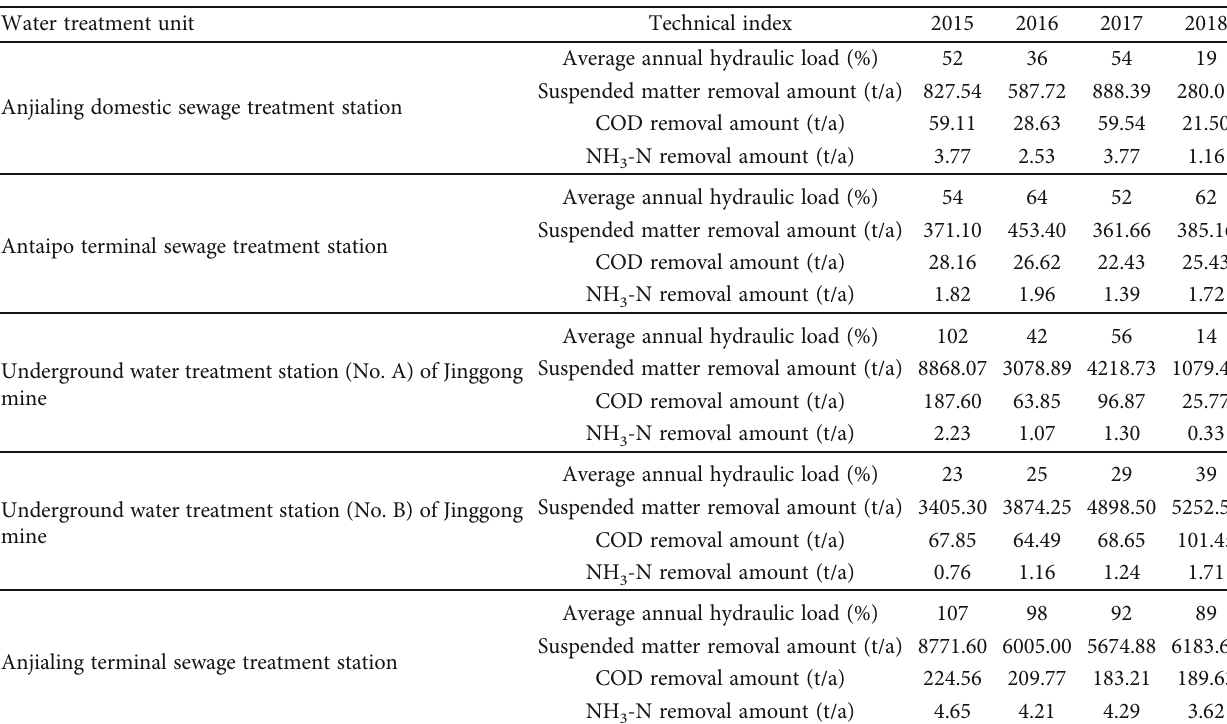
Table 10: Statistics of technical performance index of water treatment.